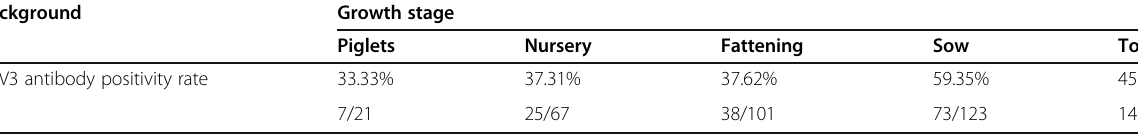
Table 3 Detection rates of PCV3 antibody Background Growth